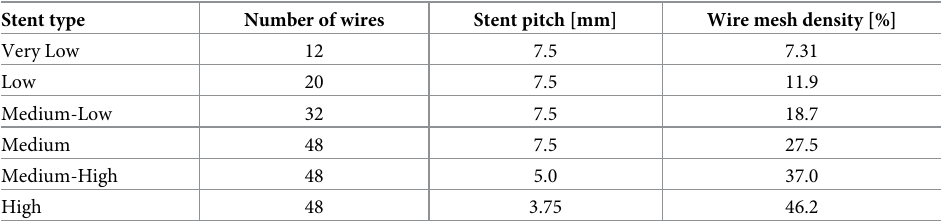
Table 1. Number of wires, stent pitch, and wire mesh density for each modeled stent